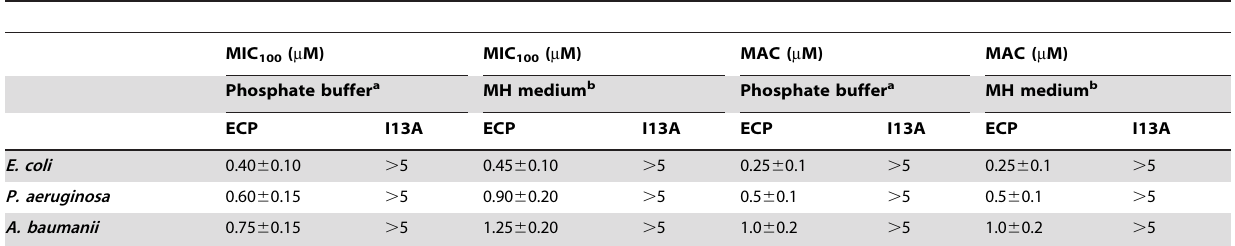
Table 1. Antimicrobial (MIC 100 ) and agglutinating (MAC) activities of wtECP and I13A mutant in Gram-negative